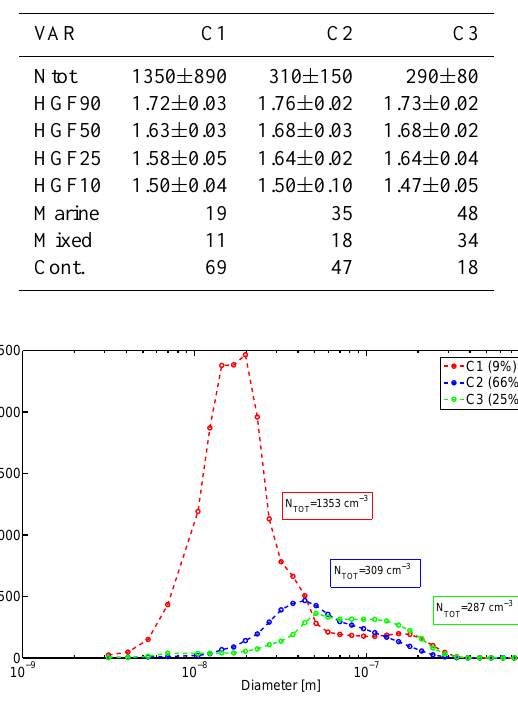
Fig. 7. The average particle number size distributions, resulting from grouping the data into three distinguishable internally similar clusters. The numbers in coloured boxes present the average to- tal number concentration in each of the clusters while the legend present the prevalence of each cluster type as